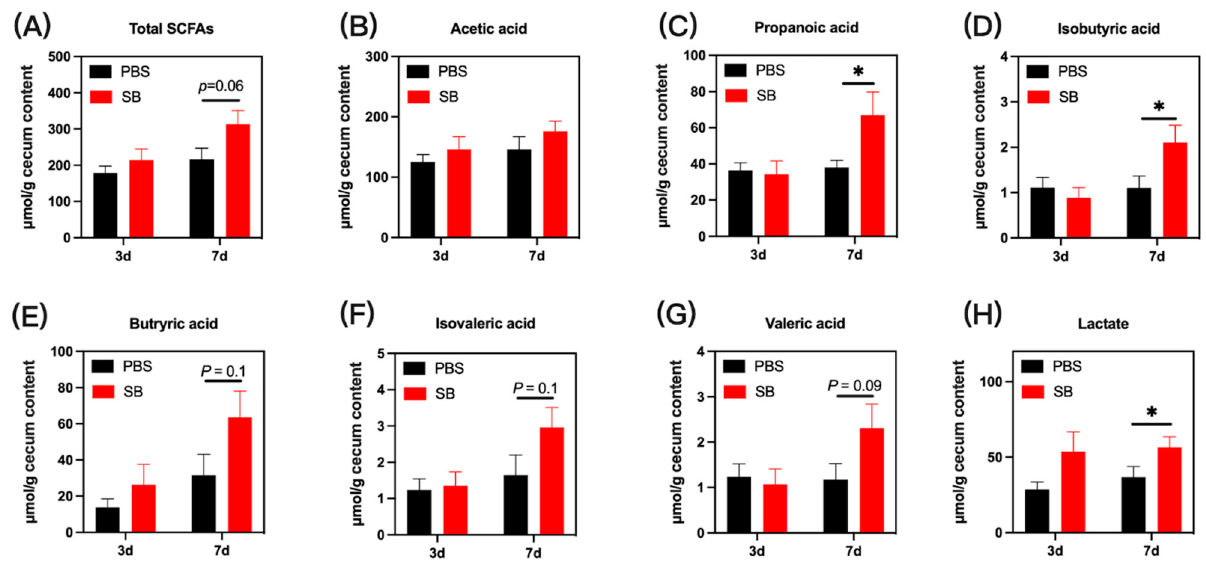
Figure 6. Effects of S. boulardii early intervention on microbial metabolites. Microbial metabolites including total SCFAs ( A ), acetic acid ( B ), propanoic acid ( C ), isobutyric acid ( D ), butyric acid ( E ), isovaleric acid ( F ), valeric acid ( G ), and lactate ( H ). Values are expressed as means ± SEM, n = 12 * p < 0.05. d, day. PBS, rats early intervened with phosphate buffer solution. SB, rats early intervened with S. boulardii